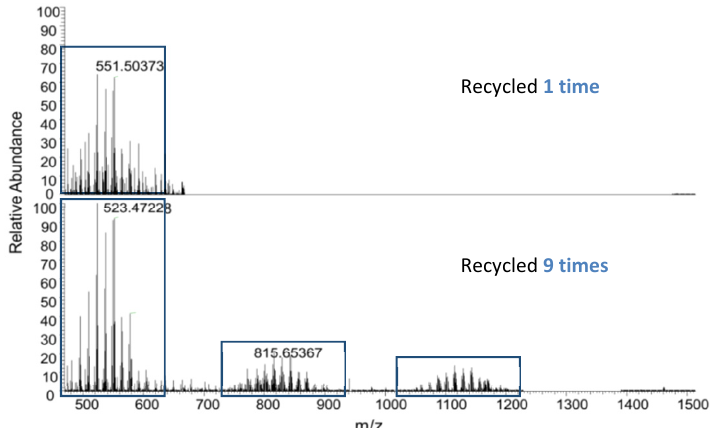
Figure 2. LESA-MS analysis on recycled bare polyethylene: upper panel - one cycle, bottom panel - nine cycles. (Reprinted from [36] with the permission of Elsevier.)